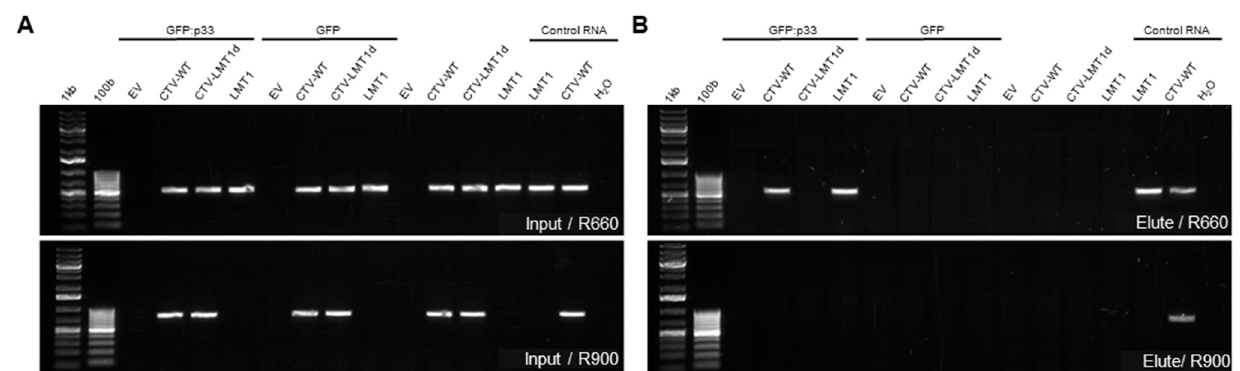
Figure 3. Non-coding sgRNA LMT1 produced from CTV binds to the p33 protein. The images show RT-PCR products analyzed by agarose gel electrophoresis. Each panel shows RT-PCR products using the total RNA extracted from the supernatant of the lysed homogenate of the leaf samples (Input, ( A )) and the total RNA extracted from GFP-Trap beads at the completion of the RIP assay (Elute, ( B )). The two sets of primers (R660 and R900) used to differentiate the shorter LMT1 RNA from the longer genomic RNA are described in Results. Control RNA samples are total RNA extracted from the leaves of N. benthamiana agroinfiltrated with a single construct as labeled. Two different molecular weight marker sets were used (1 kb and 100 b). 1 kb-marker was described in Figure 2. Another marker (100 b) has bands incremented by 100-bp size from 100 bp to 1.0 kb. EV, empty vector.